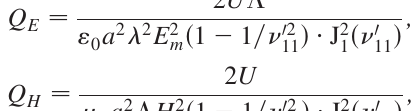
ffiffiffiffiffiffiffiffiffiffiffiffiffiffiffiffiffiffiffiffiffiffiffiffi p 1 (cid:2) ð (cid:5)=(cid:4) Þ 2